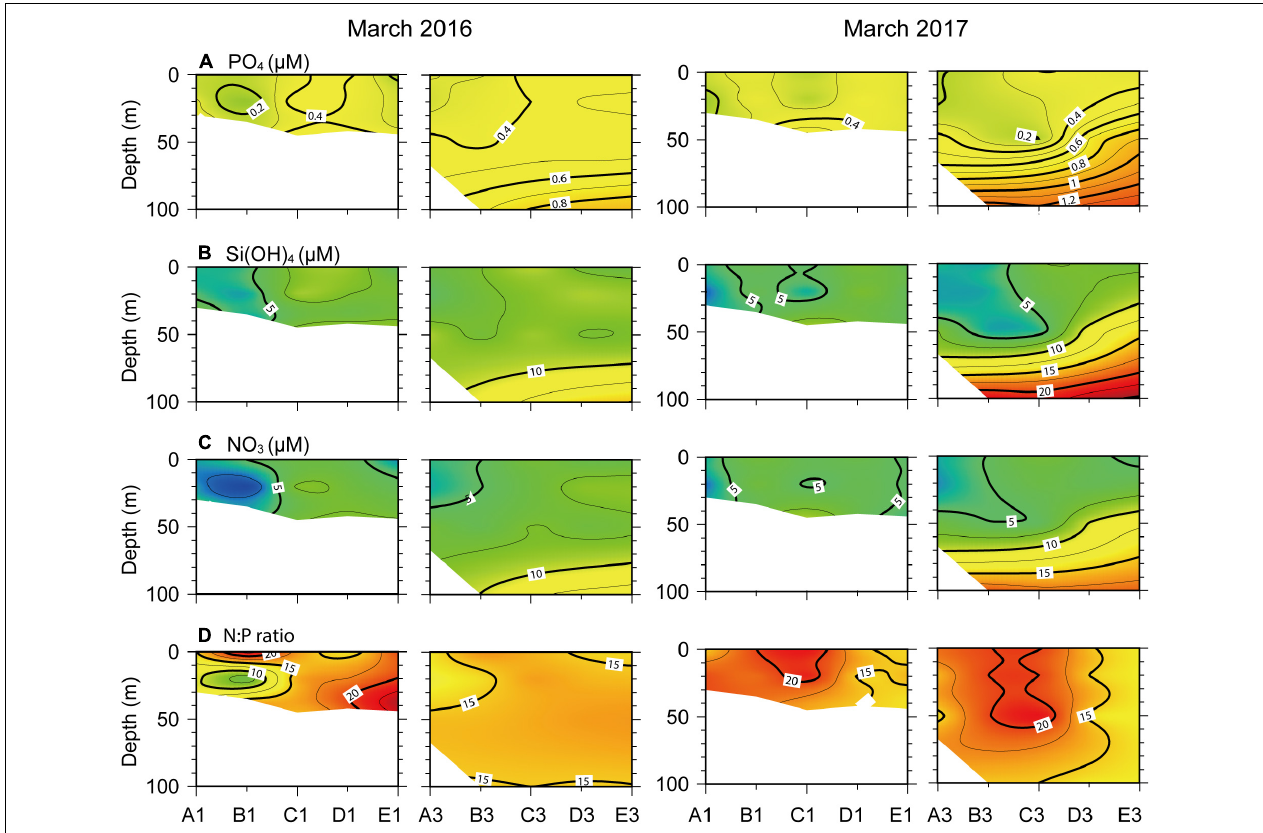
FIGURE 4 | Vertical profiles of dissolved inorganic nutrient concentrations, (A) PO 4 − , (B) Si(OH) 4 , (C) , NO 3 − , and (D) N:P ratio, across the north–south longitudinal transects of nearshore (left) and offshore (right) stations (see Figure 1 ) in March 2016 and